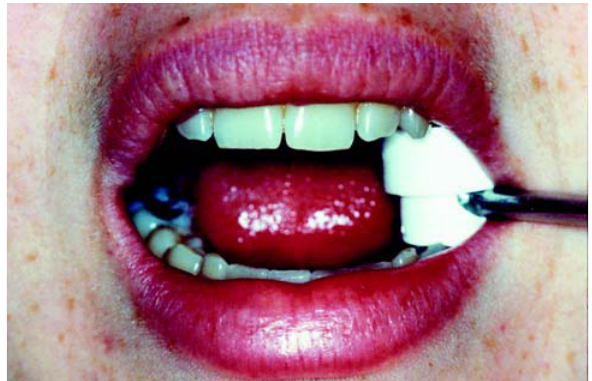
FIGURE 4- Bite force sensor at measurement position. The maximum isometric bite force was quantified at points where the subject felt safer to develop the maximum